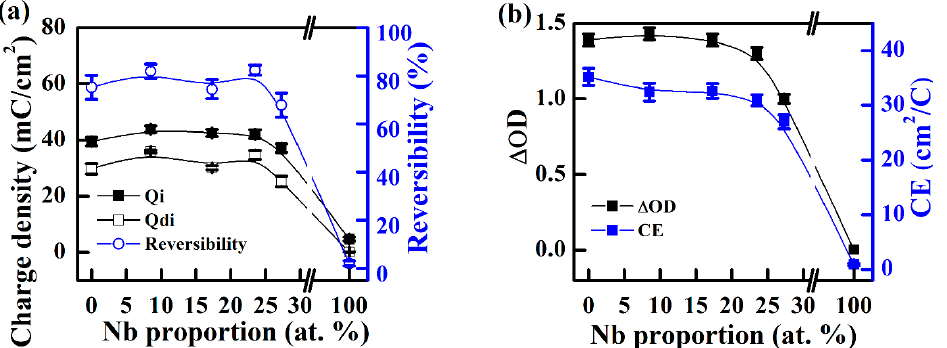
Figure 11. ( a ) Intercalated and deintercalated charge density and reversibility; ( b ) Optical density ( Δ OD) and coloration efficiency (CE) for the WO 3 , W-Nb-150w, W-Nb-250w, W-Nb-350w, W-Nb-450w, and Nb 2 O 5 films.